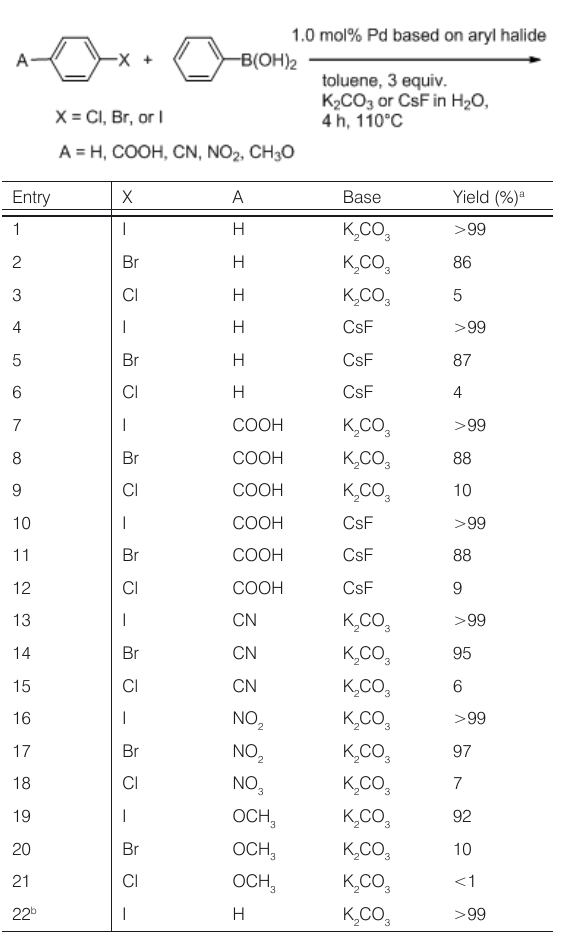
Table 1. Suzuki cross-coupling reaction in toluene catalyzed by pal- ladium